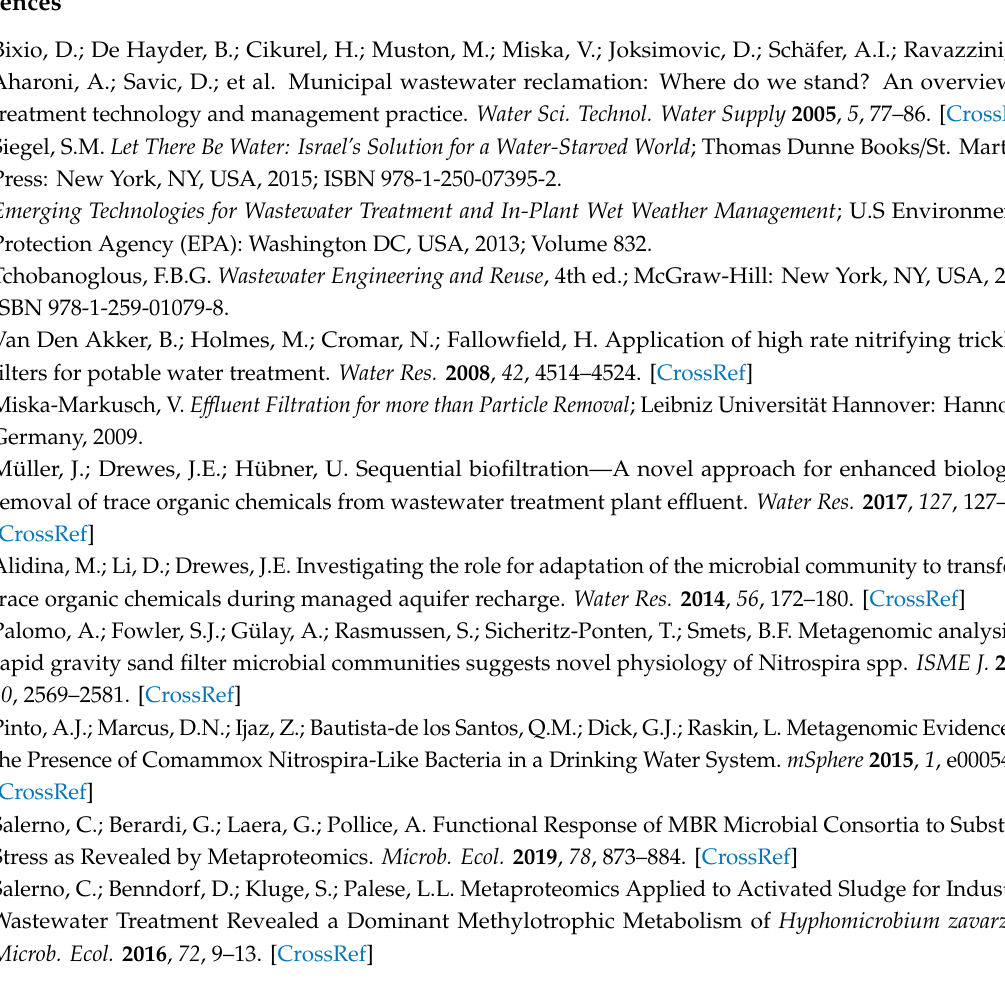
Figure A6. Concentrations and removal of nitrite (mg / L-N) over sampling campaigns, before the biofilter (BF) and after the biofilter (AF) with H 2 O 2 addition, also sorted by feed values of ammonium. No H 2 O 2 campaigns are circled in orange.